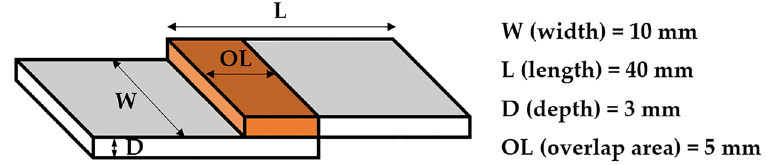
Figure 8. Dimensions for single lap shear test of EP series.